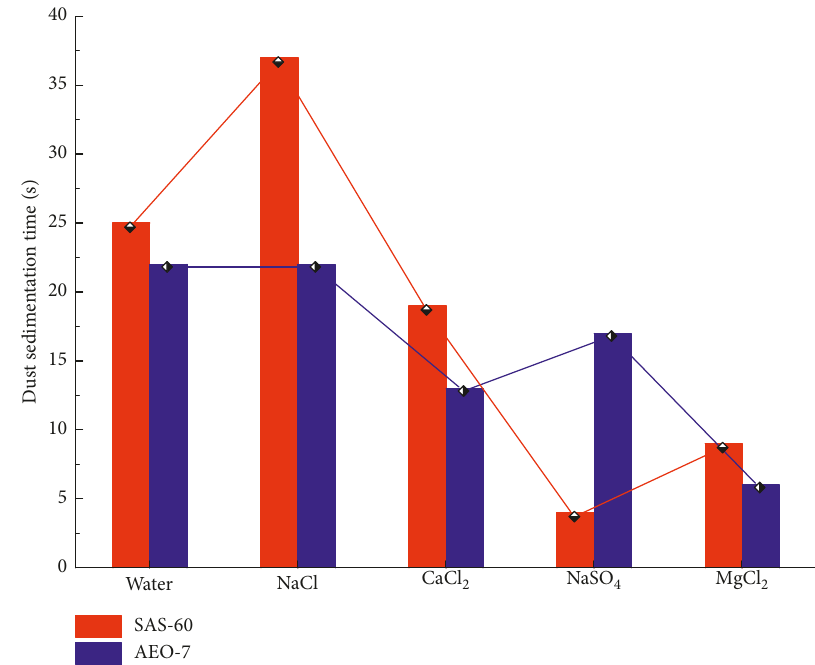
Figure 3: Impacts of the synergists on the wetting performances of SAS-60 and AEO